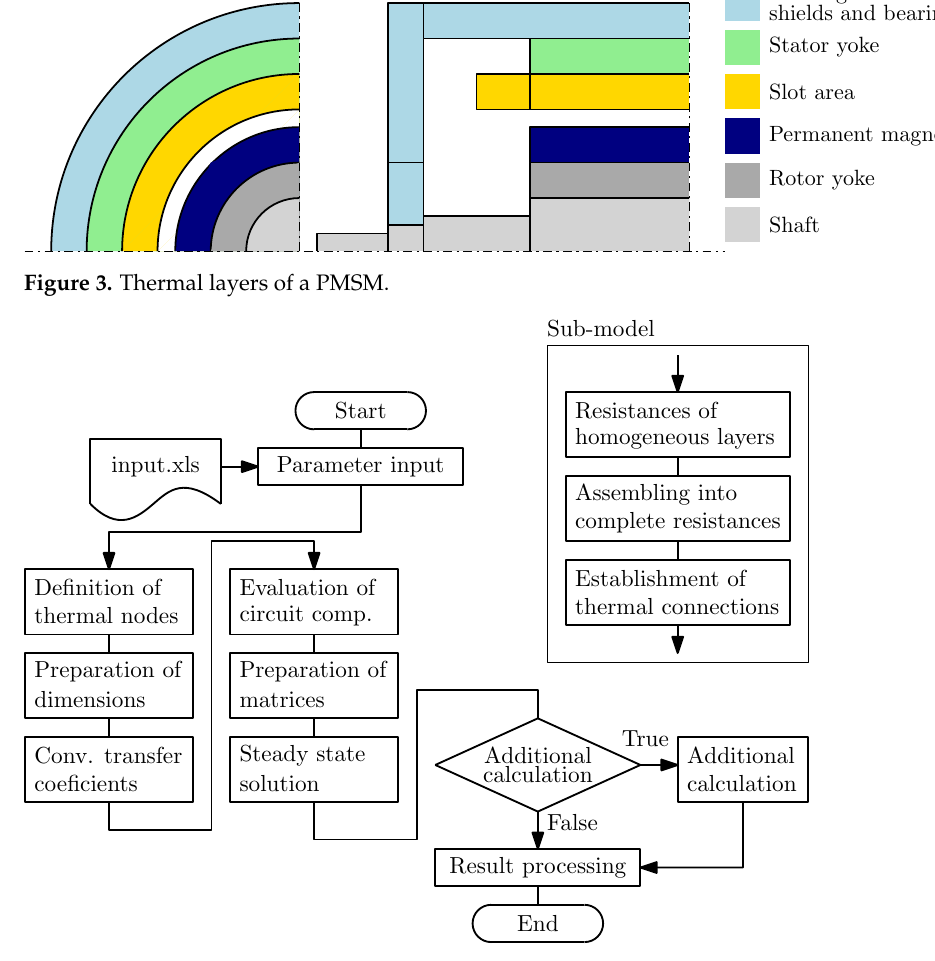
Figure 4. Flowchart of LPTN-based